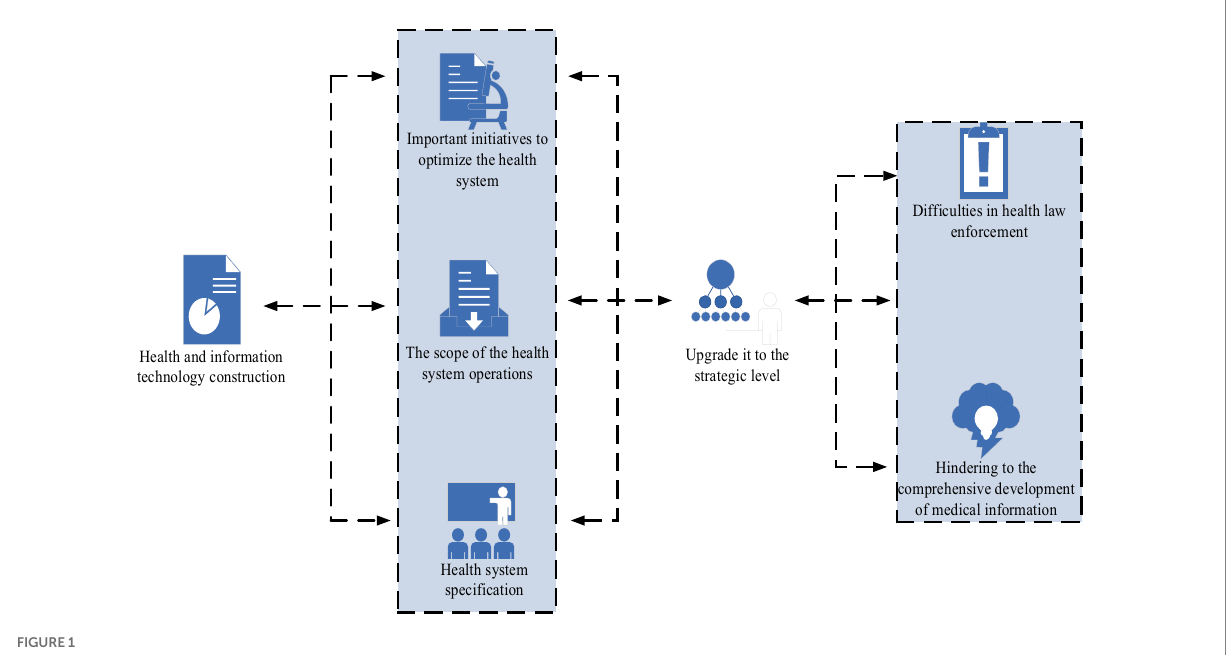
FIGURE 1 Current situation of health informatization